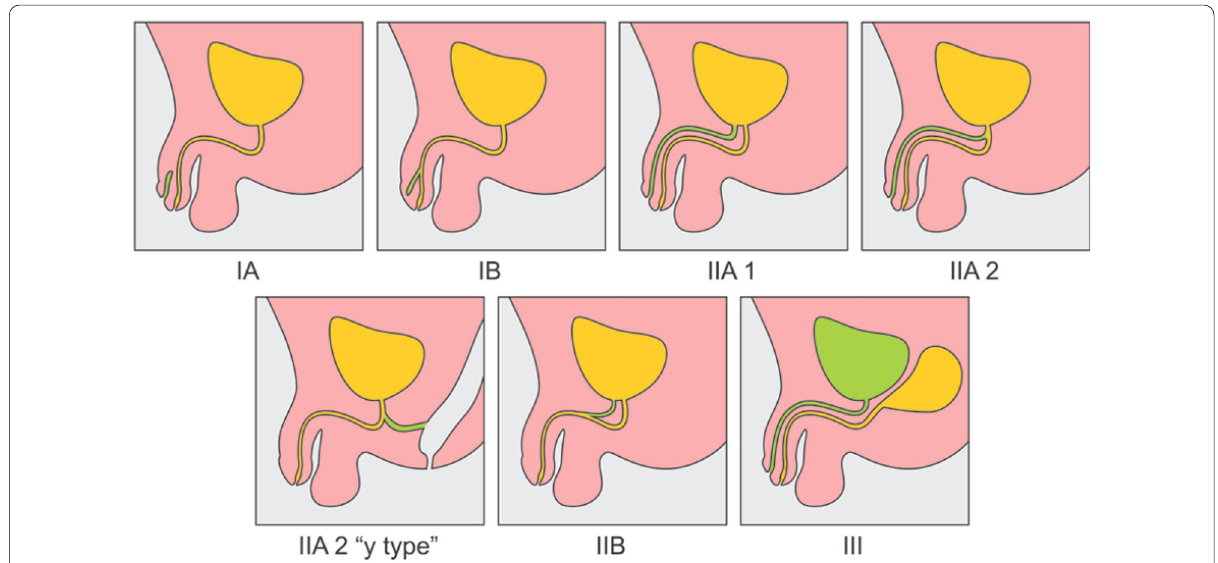
Fig. 2 Effmann’s classification for urethral